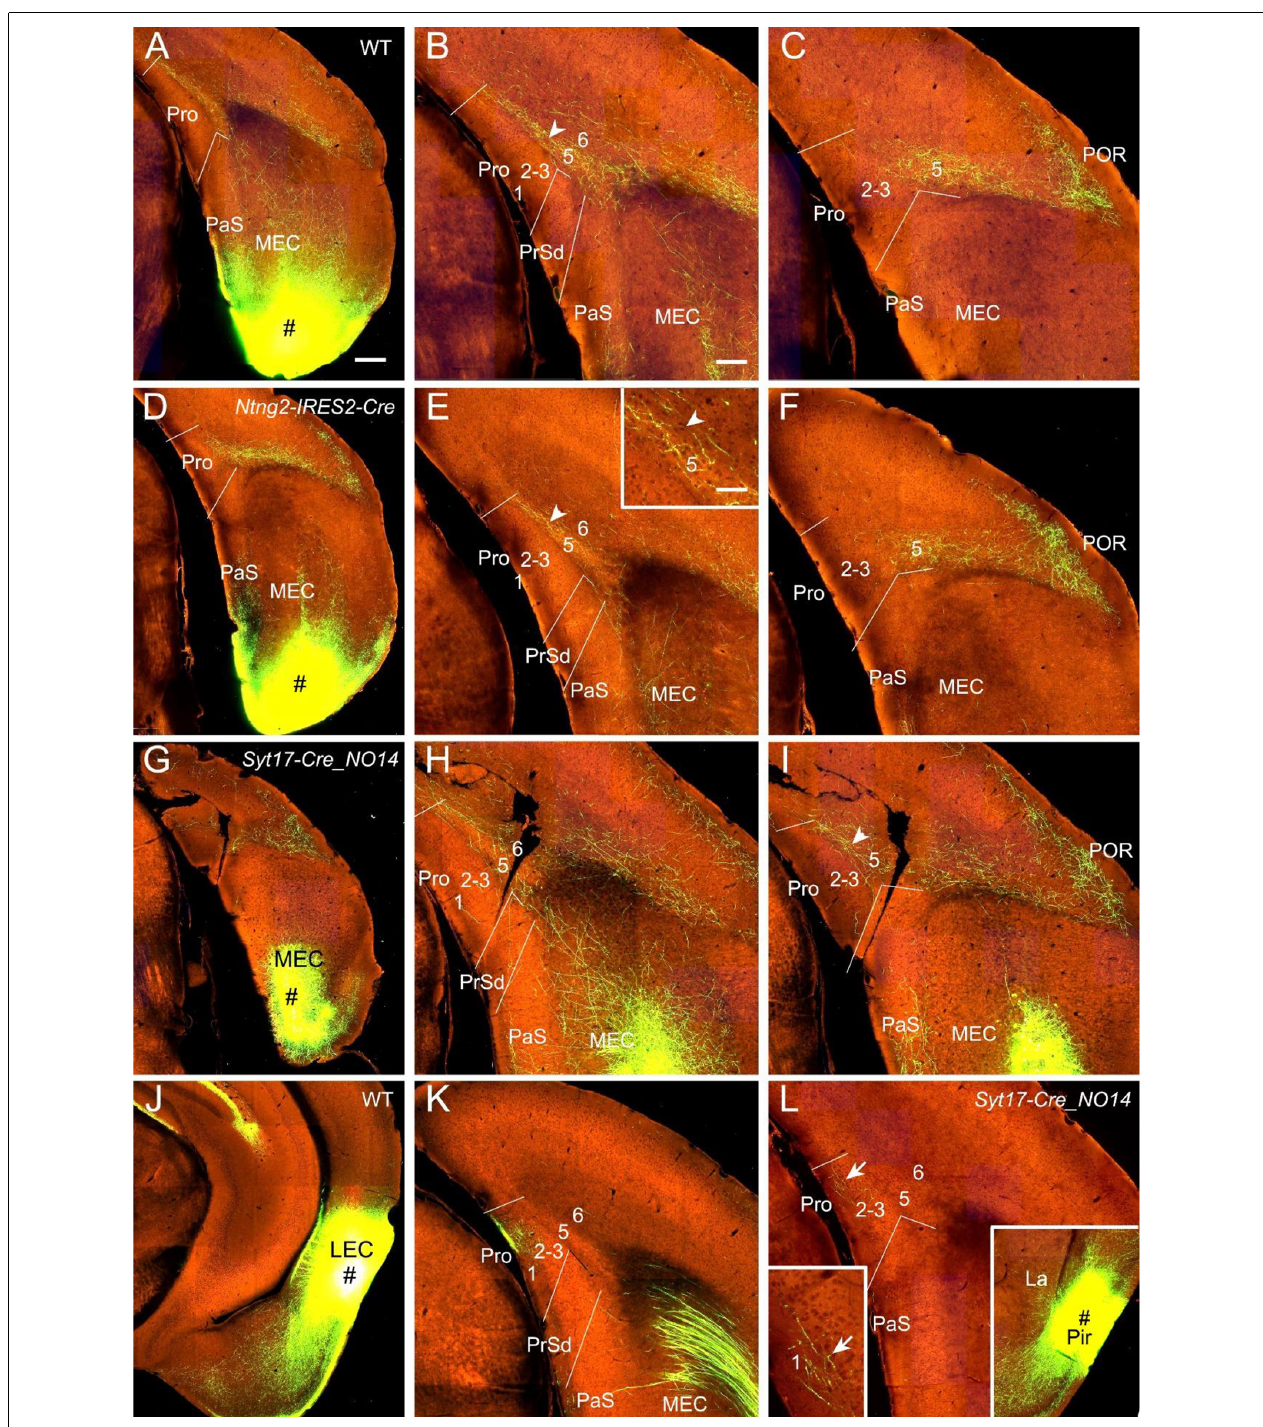
FIGURE 6 | Projections from entorhinal and piriform cortices to the Pro. (A–C) An injection in MEC (# in A ) of a WT mouse yields strong terminal labeling in L5 of the Pro (B,C) . ( D–F) An injection in MEC (# in D ) of a Ntng2 -IRES2-Cre mouse (Cre expression in L2) produces moderate terminal labeling in L5 of the Pro (E,F) . The Pro labeling in (E) is magnified in the inset. ( G–I) An injection in MEC (# in G ) of a Syt17 -Cre_NO14 mouse (Cre in L2 and L5) results in moderate terminal labeling in L5 of the Pro (H,I) . (J,K) One LEC injection (# in J ) in a WT mouse results in strong and weaker terminal labeling in L1 and L2–3 of the Pro, respectively (K) . (L) Weak terminal labeling in L1 of the Pro after an injection was placed in the piriform cortex (# in the right inset) of a Syt17 -Cre_NO14 mouse (Cre in L2–3). The labeling in L1 of the Pro is magnified in the left inset. Arrowheads and arrows point to the labeling in L5 and L1, respectively. Bars: 350 µ m in (A) (for A , D , G , J , and the right inset in L ); 200 µ m in (B) (for other panels); 70 µ m in the inset in (E) (also for the left inset in L ).